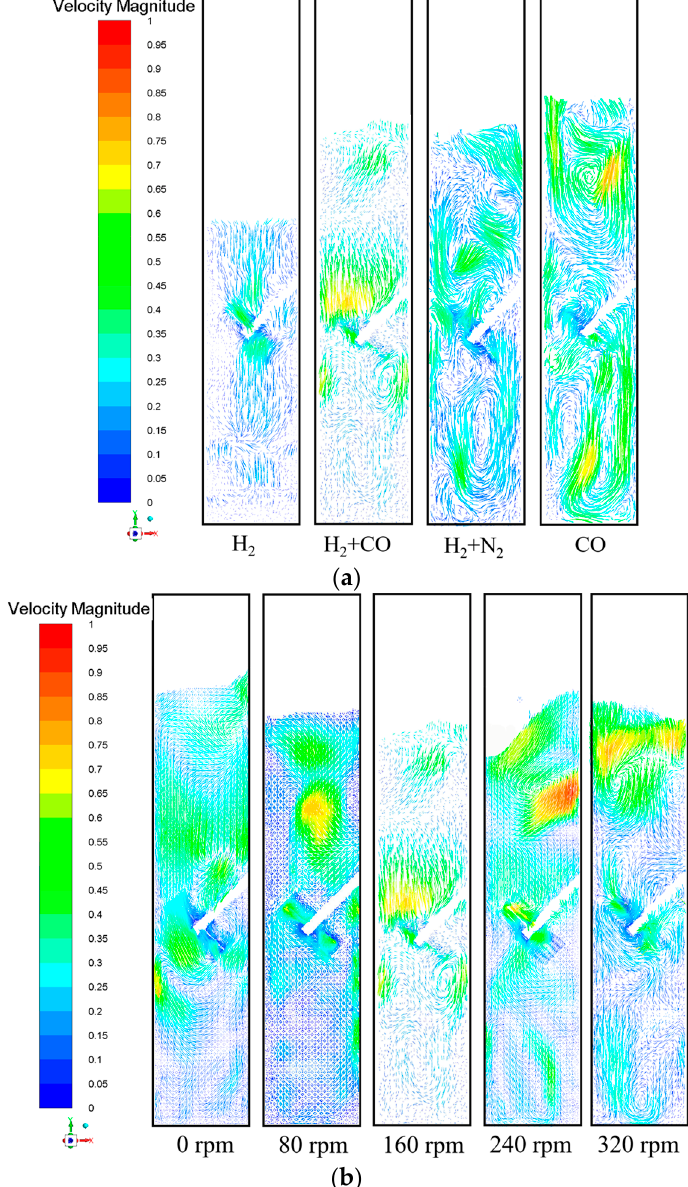
Figure 7. Velocity vector diagram of iron ore powder particles. ( a ) Different gas compositions. ( b ) Different agitation speeds.